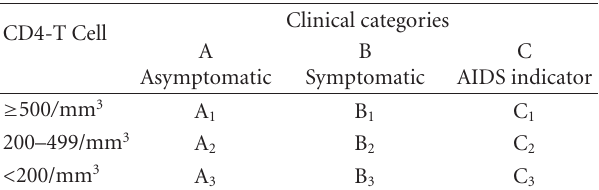
Figure 1: Intraoral picture showing the left retrocommissural area and buccal mucosa. Table 1: Revised CDC classification and case definition among adults (1993).